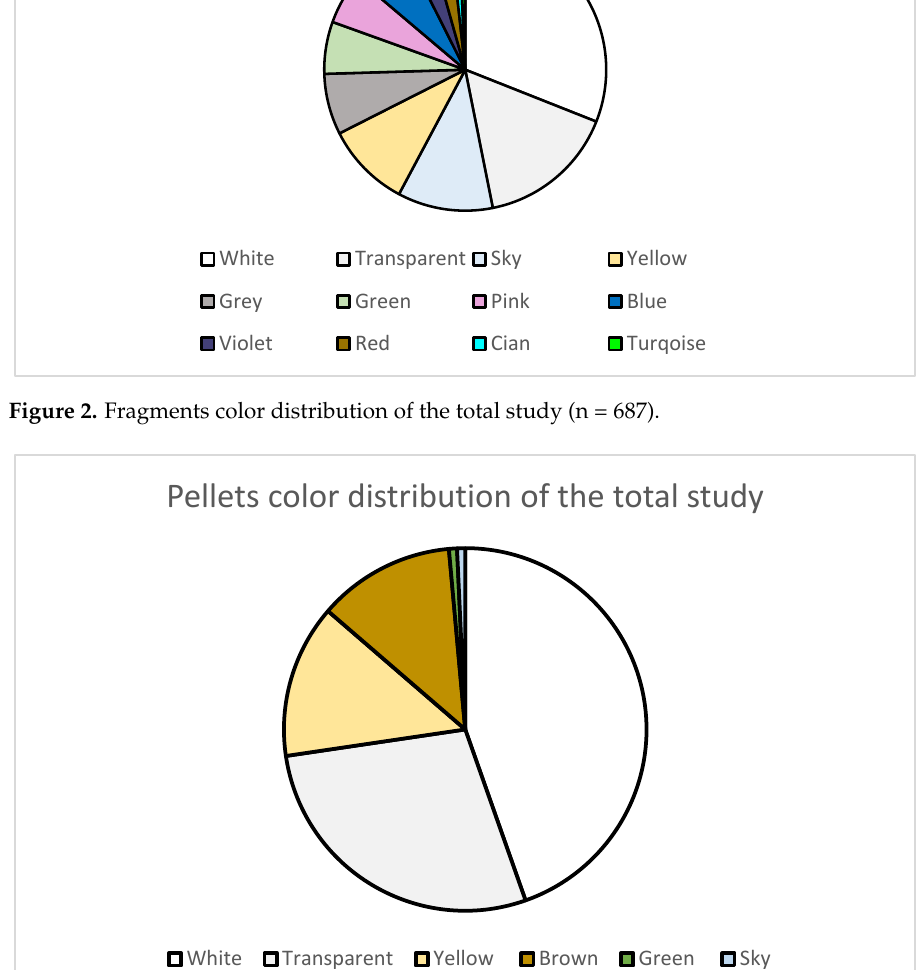
Figure 2. Fragments color distribution of the total study (n = 687).